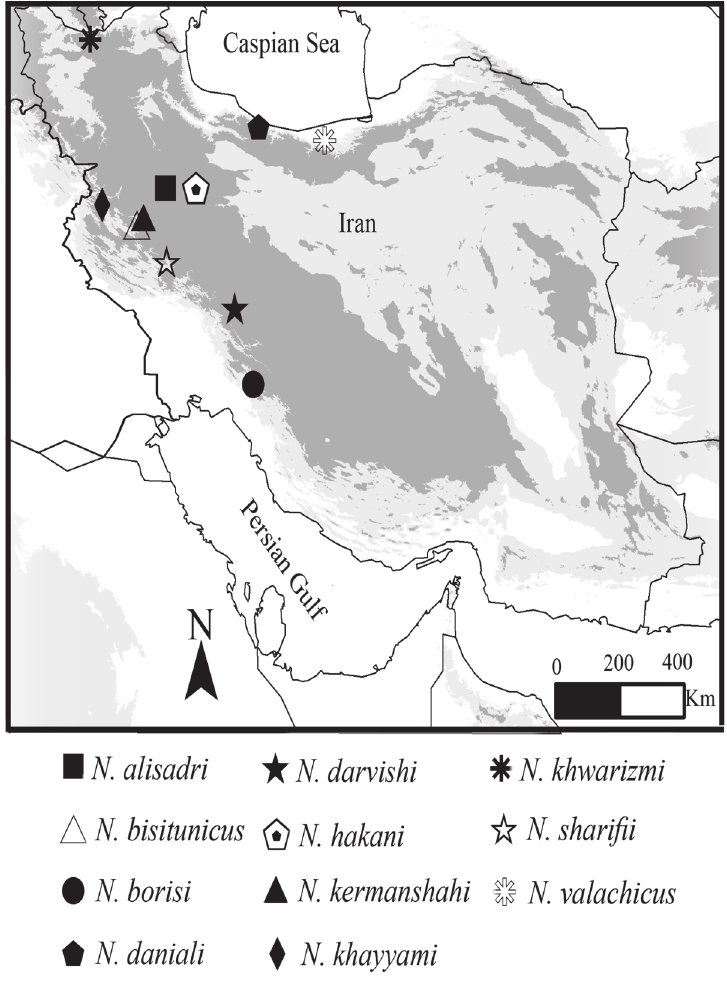
Figure 1. Distribution map of the members of genus Niphargus in Iran. marus crassus (Sars G.O., 1894), and Gammarus fossarum Koch, 1836, were used as outgroup (KF719240, KF719242 and KF71924). All the sequences were edited and aligned using ClustalW (Thompson et al. 1994), as implemented in the Bioedit